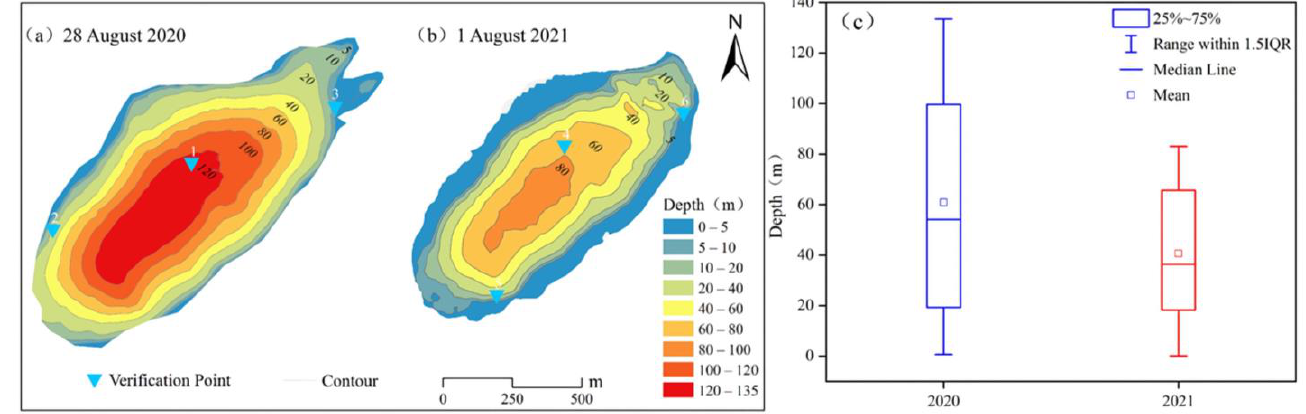
Figure 8. Depth survey map of Jialong Co glacial lake. ( a ) Depth survey map on 28 August 2020. ( b ) Depth survey map on 1 August 2021. ( c ) Depth distribution box plot.